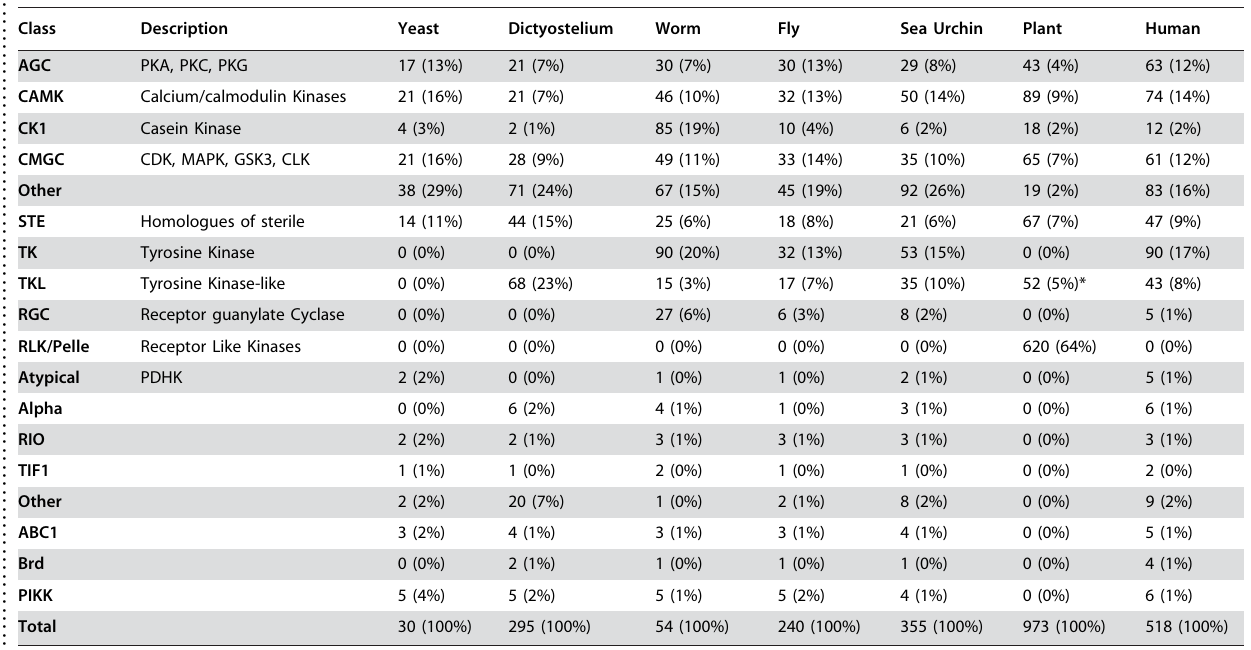
Table 1. Classification of the different kinases in major groups and the numbers of members detected in different organisms by genetic screens (general estimates). .. ... .... ... ... .... ... ... .... ... ... .... ... ... .... ... ... .... ... ... .... ... ... .... ... ... .... ... ... .... ... ... .... ... ... .... ... ... .... ... ... .... ... ... .